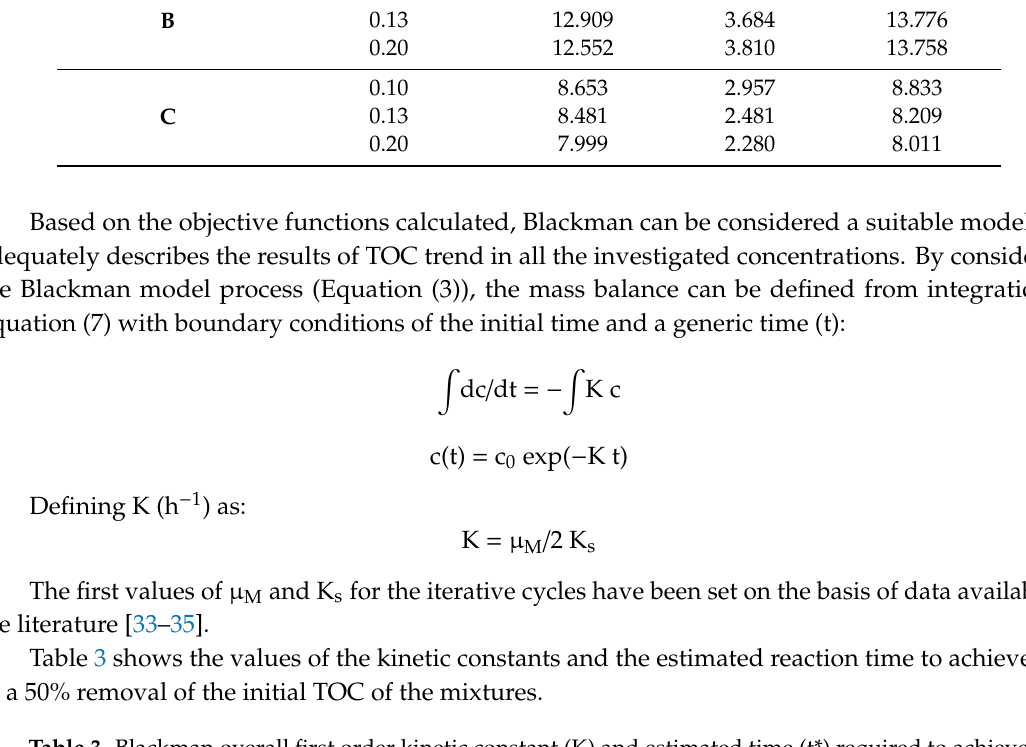
Table 3. Blackman overall first order kinetic constant (K) and estimated time (t*) required to achieve the 20 and 50% of TOC 0 (t* 20% and t* 50% ). Conditions: T = 30 ◦ C and pH =